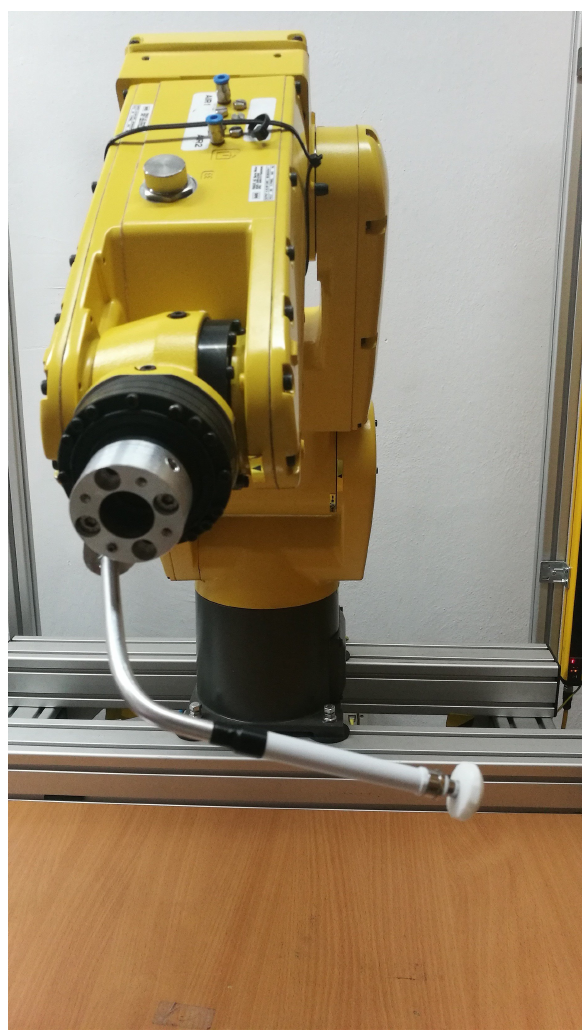
Figure 8. Robot with pressing